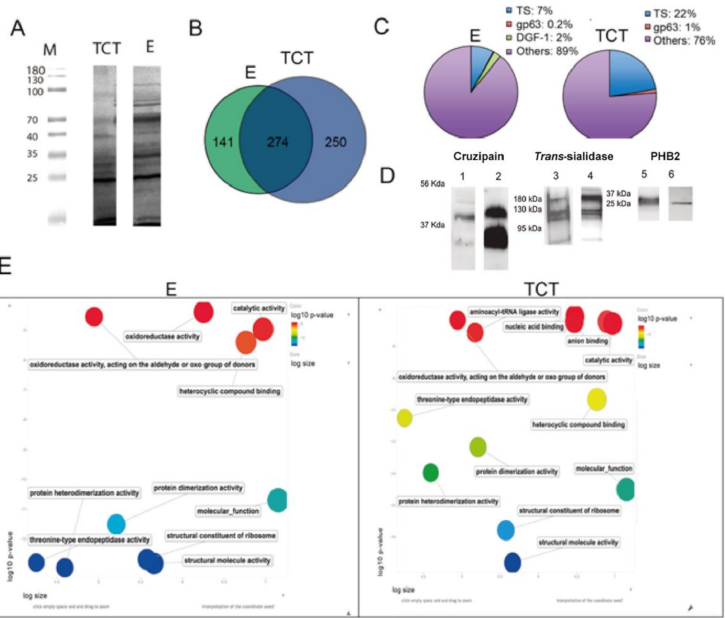
Figure 2. Qualitative proteomic analysis of the cargos of EVs of E and EVs of TCT of T. cruzi . ( A ) Western blot and differential protein profile of EVs of E and EVs of TCT using polyclonal anti- T. cruzi antibodies. ( B ) Venn diagram of specific and shared proteins of EVs of E and EVs of TCT. ( C ) Pie chart representing the percentage of proteins of EVs of E and EVs of TCT that belong to multigene families. ( D ) Western blot analysis for the confirmation of cruzipain, trans -sialidase [8] and prohibitin 2 (PHB2) in EVs of T. cruzi: (1) cruzipain in whole lysates of TCT; (2) cruzipain in EVs of TCT; (3) trans -sialidase (mAb 39) in whole lysates of TCT; (4) trans -sialidase (mAb 39) in EVs of TCT; (5) PHB2 in whole lysates of E; and (6) PHB2 in EVs of E. ( E ) Scatter plot representing Gene Ontology (GO) terms enrichment analysis of proteins of the EVs of E and EVs of TCT, categorized by molecular function ( p ≤